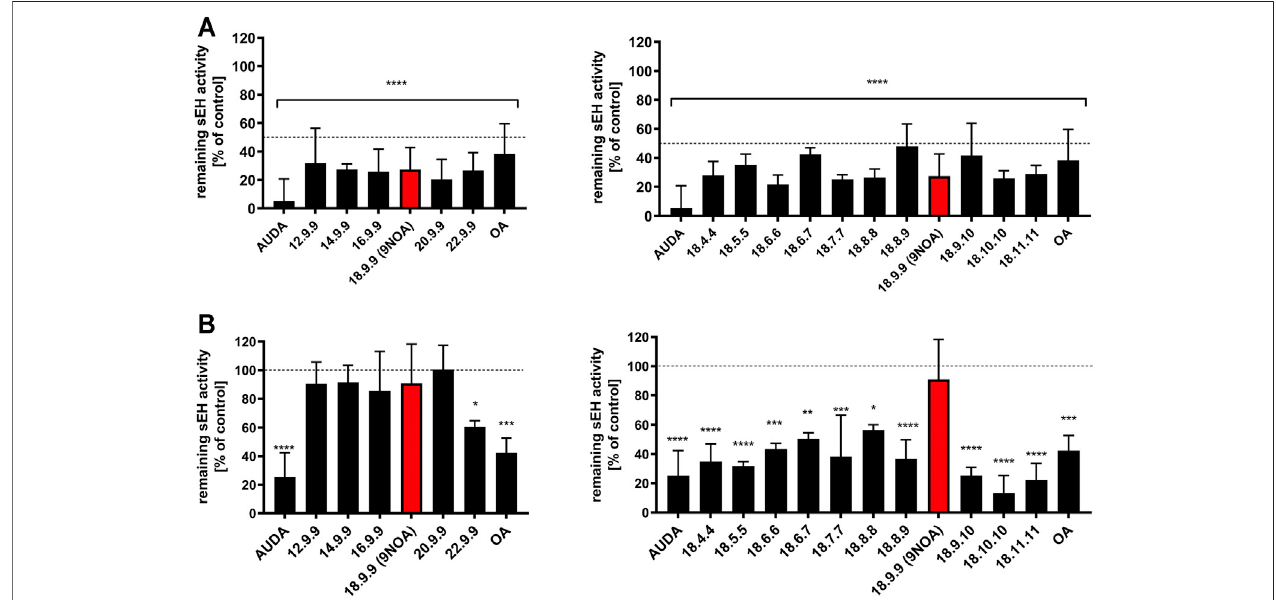
FIGURE 3 | Effects of NFA on sEH activity. (A) Human recombinant sEH was incubated with 100 nM OA and NFA of different carbon chain lengths and Michael acceptor positions. AUDA (10 nM) served as the positive control. sEH activity was measured by the release of 6-methoxy-2-naphthaldehyde from epoxidized PHOME. Data are the mean ± SEM of n (cid:2) 3 – 7. (B) sEH activity of HepG2 cells treated with NFA and AUDA (10 µM) for 24 h. The cells were lysed, and hydrolase activity was measuredbyEpoxyFluor7lysis.DatahavebeennormalizedagainstDMSOcontrolandthereforearepresentedasthepercentofthecontrolmean ± SEM, n (cid:2) 2 – 3. Statistical signi fi cance was calculated by one-way ANOVA with Bonferroni post-test and multiple comparisons against the DMSO control. As indicated all data are signi fi cantat**** p ≤ 0.0001.* p ≤ 0.03,** p ≤ 0.0021,*** p ≤ 0.0002arealsoconsideredsigni fi cant.sEH,solubleepoxidehydrolase;OA,oleicacid;NFA,nitro-fatty acids;